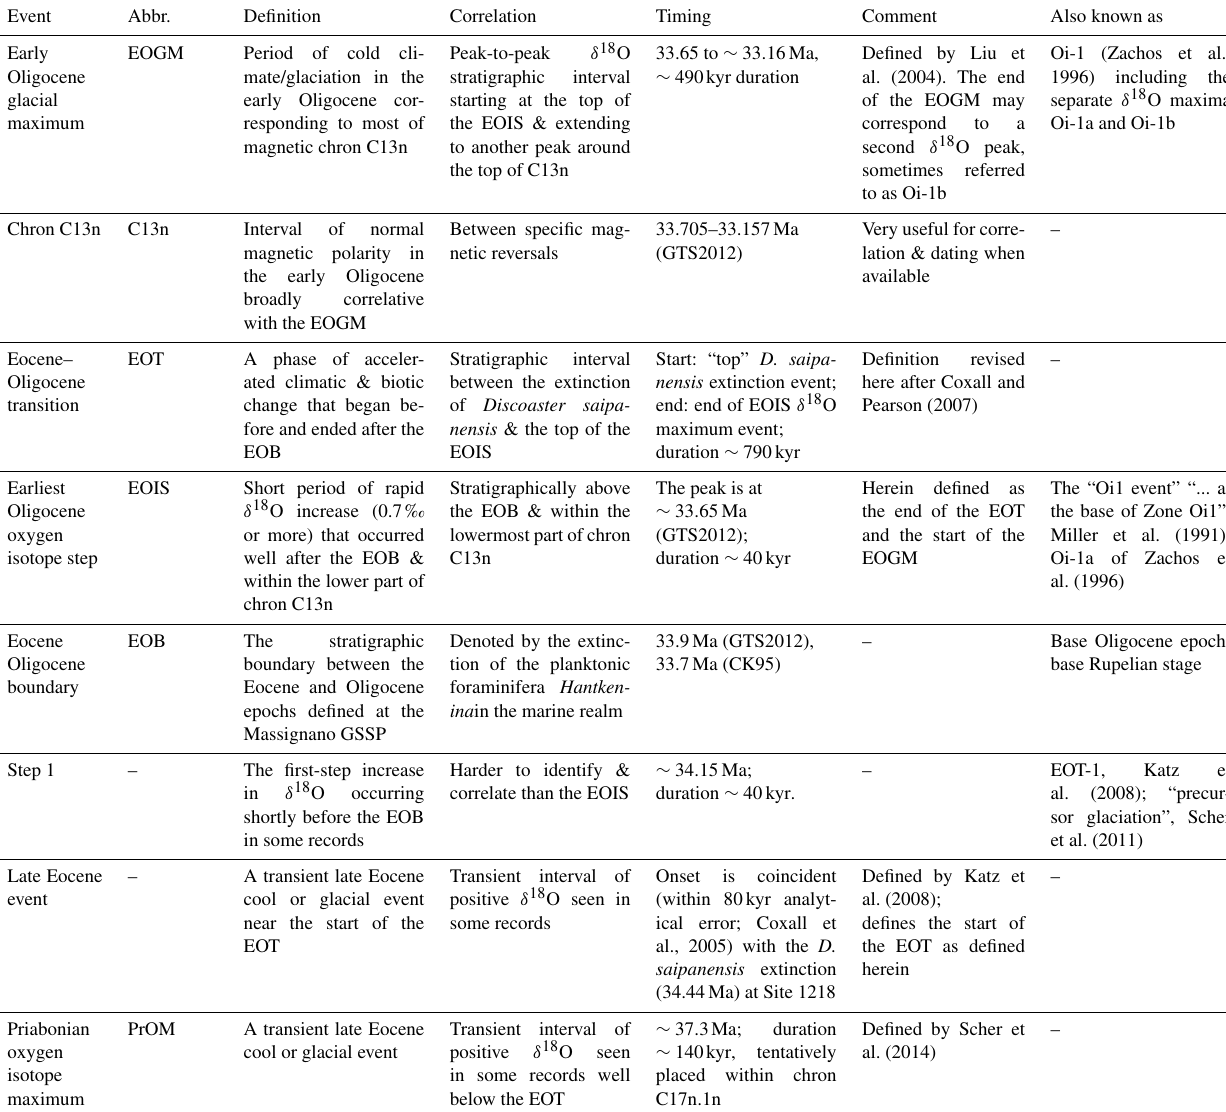
Table 1. Summary of Eocene Oligocene terminology and approximate timings of events, as interpreted at the time of writing. Timescales referred to are GTS2012 (Gradstein et al., 2012) and CK95 (Cande and Kent,